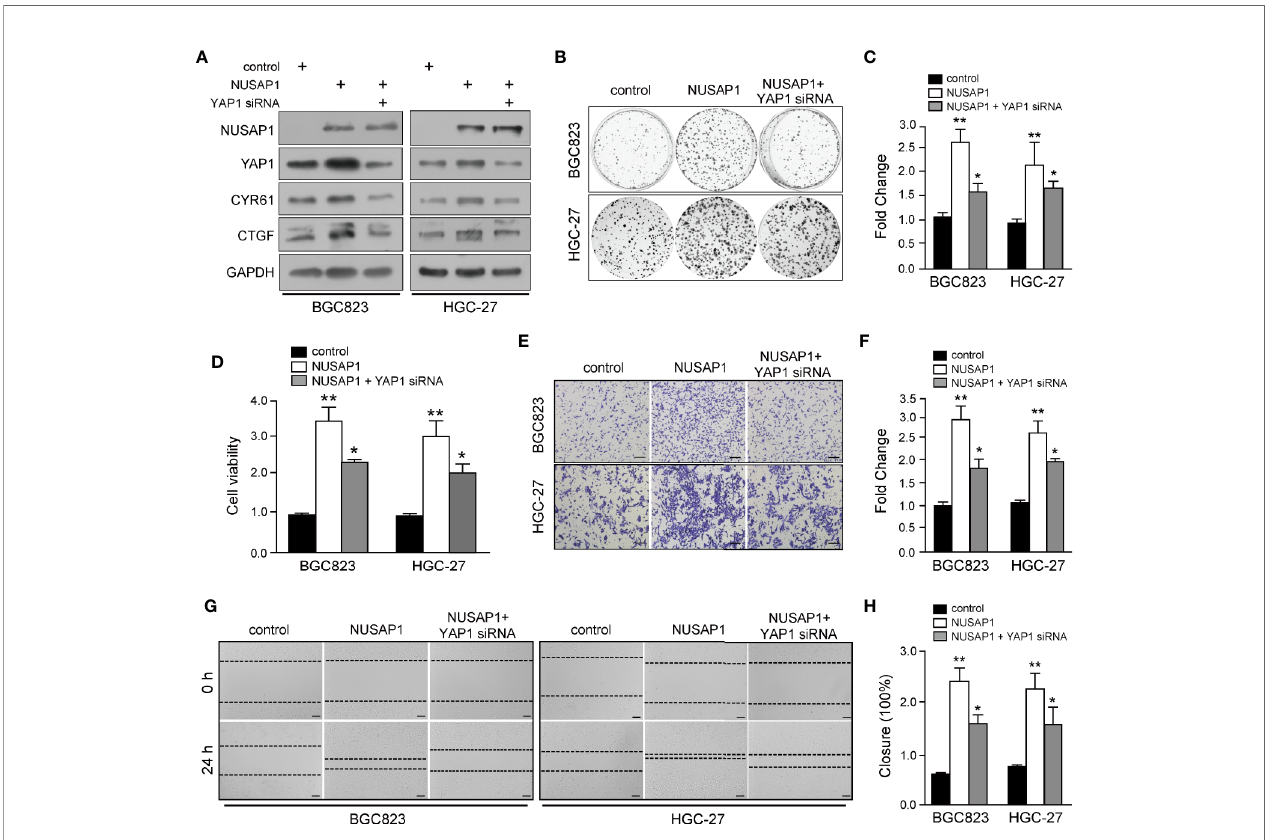
FIGURE 6 | YAP1 functions as a downstream mediator of NUSAP1 to accelerate GC cell proliferation and invasion. (A) Western blotting analysis of lysates prepared from NUSAP1-overexpressing GC cells with YAP1 siRNA. GAPDH was used as a loading control. (B) Colony formation assay performed on NUSAP-overexpressing BGC823 and HGC-27 cells with YAP1 knockdown. (C) Graphic representation of the colony numbers under the indicated transfection condition. (D) CCK-8 assay performed on NUSAP-overexpressing BGC823 and HGC-27 cells with YAP1 knockdown. (E) Representative images of fi xed and stained Transwell invasion assays performed on modi fi ed BGC823 and HGC-27 cells (magni fi cation, ×200). (F) Graphic representation of invaded cell counts from the Transwell assays. (G, H) Cell migration ability evaluated by wound-healing assays performed on modi fi ed BGC823 and HGC-27 cells (magni fi cation, ×200). One-way analysis of variance (adjusted for Bonferroni correction test). All data are presented as the mean ± SEM of triplicate experiments, n =3, * P <0.05 and ** P